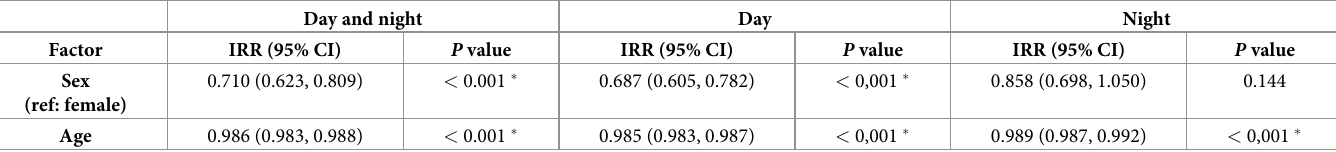
Table 1. Variables of the GEEs with significant effects on the age-specific activity of flies during the 24h day-night interval, the daytime and the nighttime periods, for their entire lifespan, by the factors: Sex (males, females) and age.